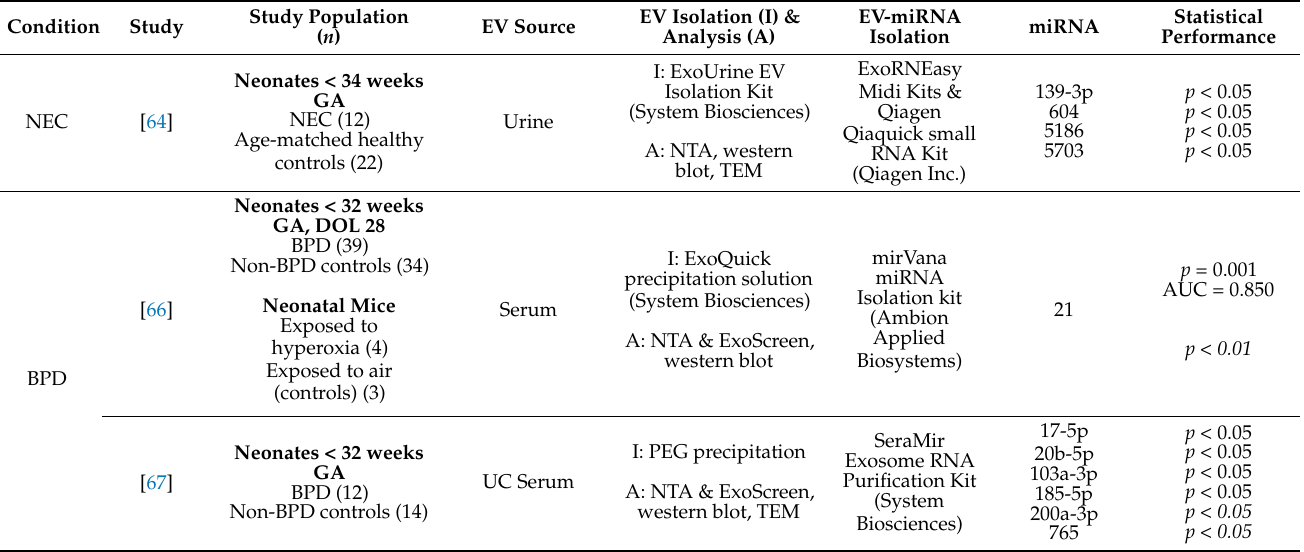
Table 1. Summary of EV-miRNAs in NEC, BPD,